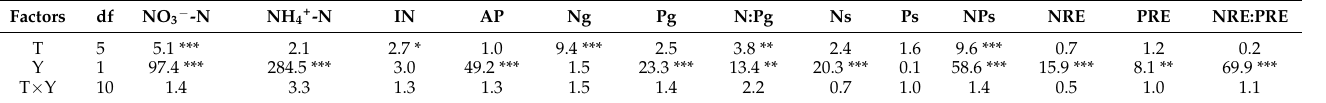
Table 1. Results of the two-way ANOVA for nutrient concentrations and nutrient resorption effi- ciencies as dependent on years (Y), treatments (T), and their interactions.